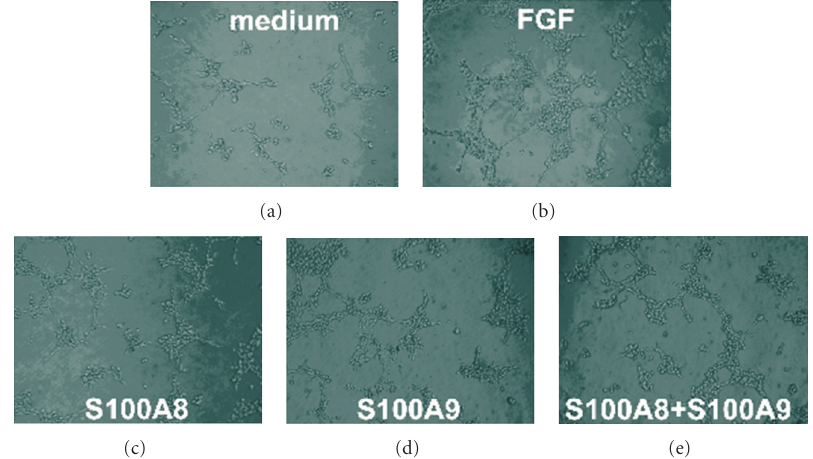
Figure 3: Tube-like structure formation of HUVEC seeded on Matrigel with or without S100A8 or S100A9 protein in vitro (both at 10 μ g/mL). FGF plus heparin was used as a positive